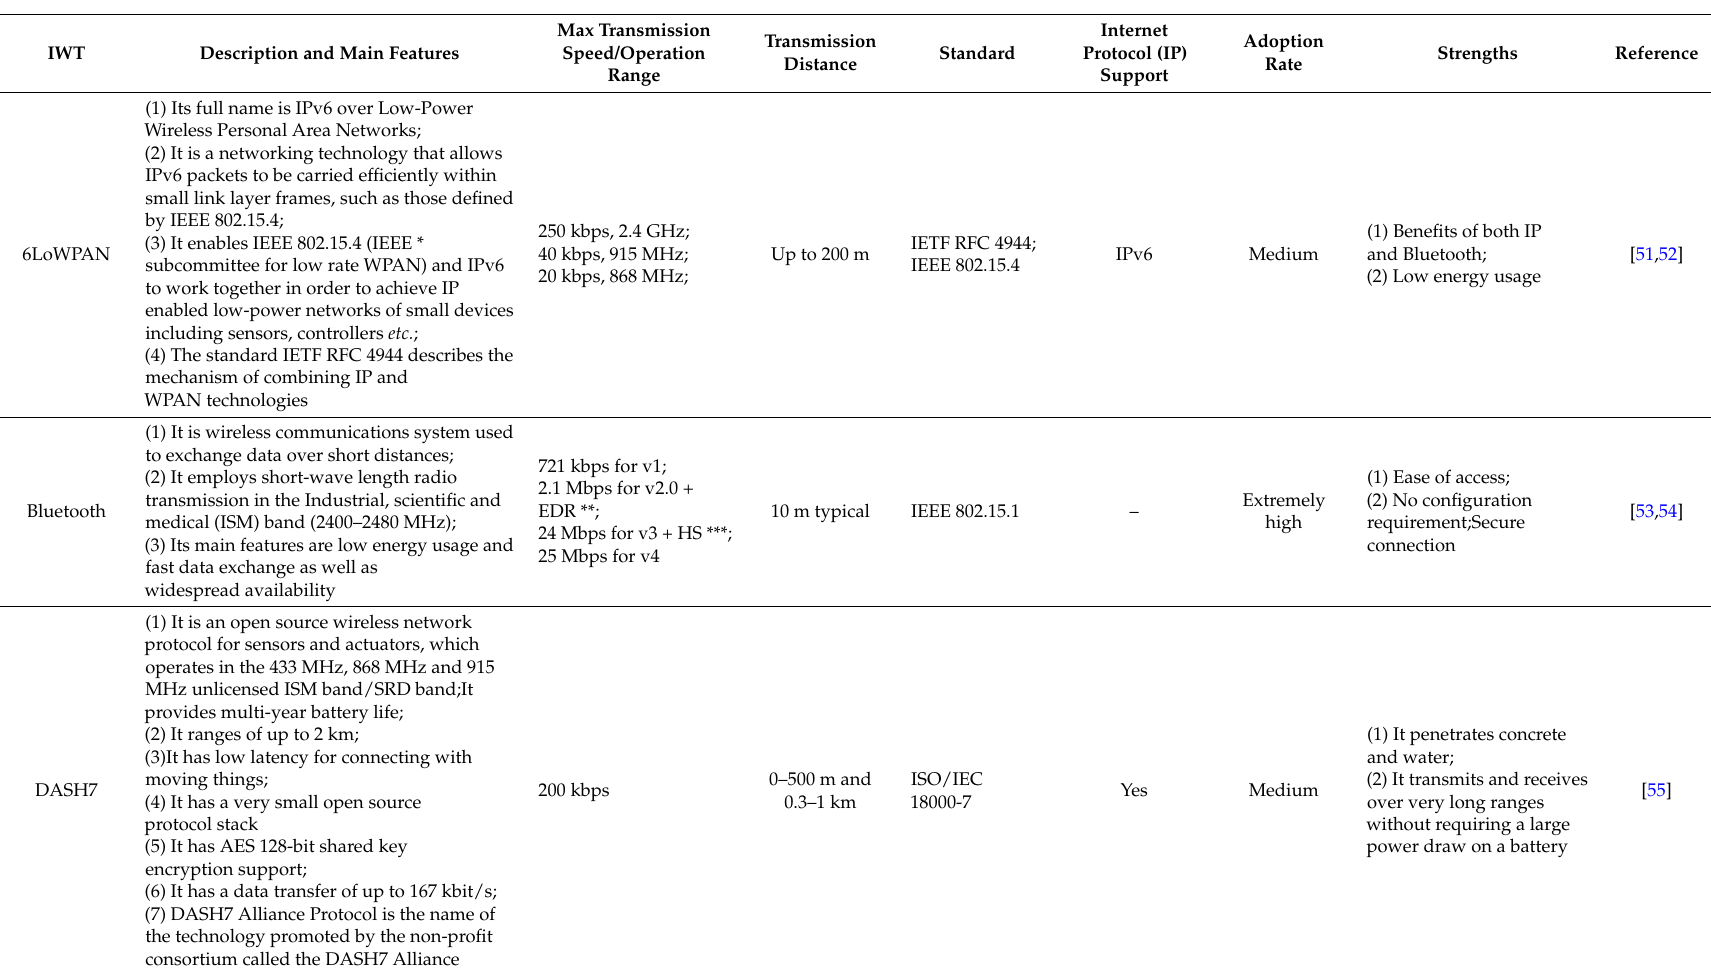
Table 2. Comparison among the different integrated wireless